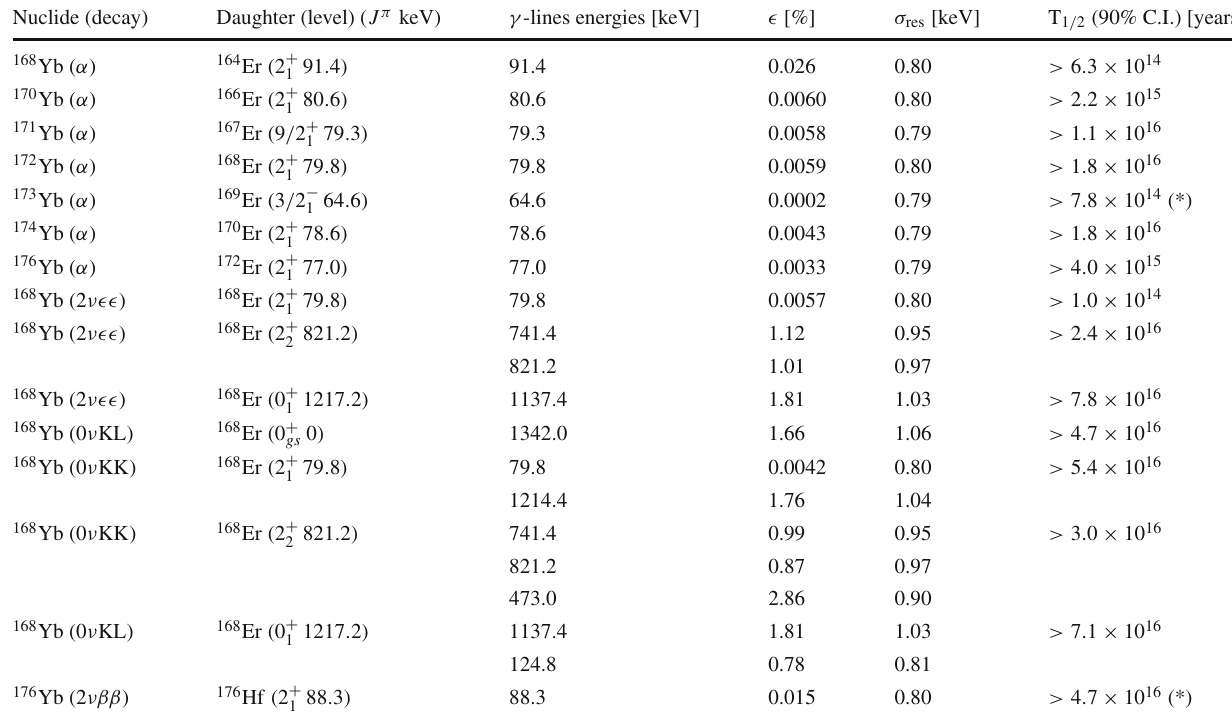
bined fit is used for the limit setting. (*) No discovery is possible for thesedecaymodesinthissearchduetooverlappingbackground γ -lines. The given limits are valid